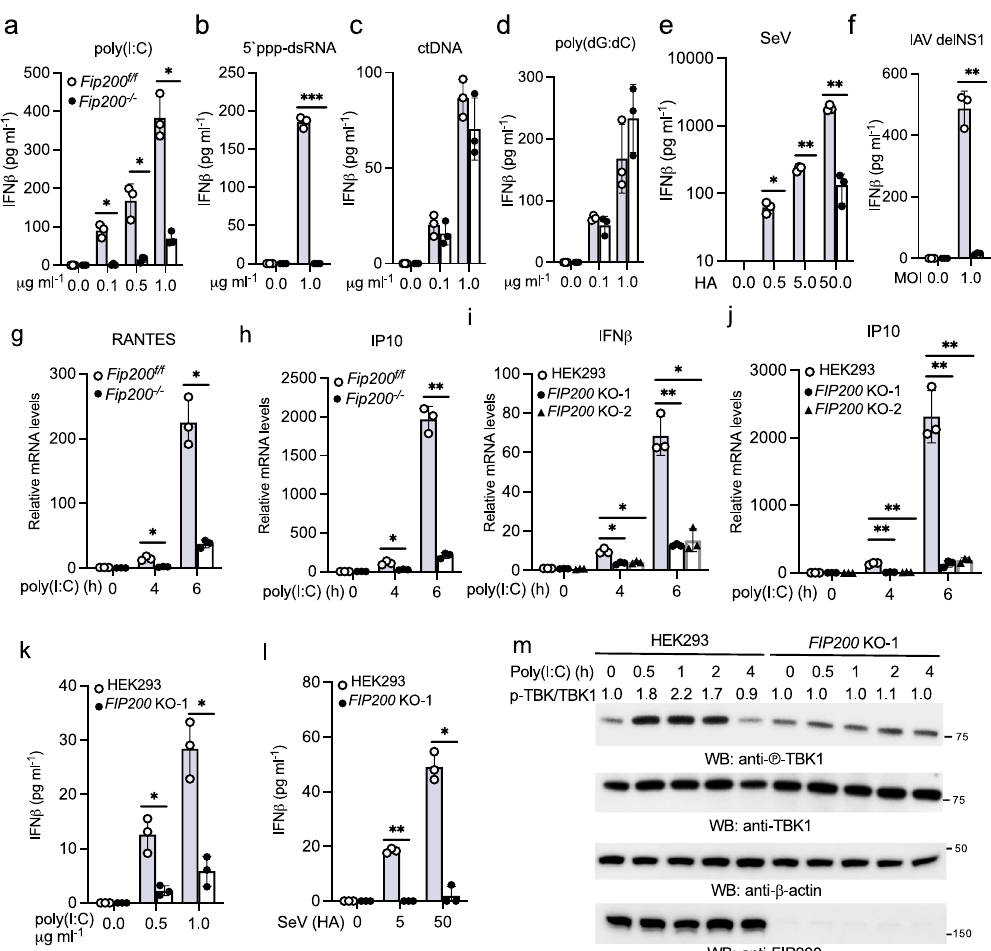
Fig. 3 FIP200 de fi ciency impairs RIG-I activation in fi broblasts. a – d Fip200 f/f and Fip200 − / − MEFs were transfected with indicated amount of poly(I:C) ( a ), 5 ′ ppp-dsRNA ( b ), calf thymus DNA (ctDNA) ( c ), or poly(dG:dC) ( d ). After 16 h, the supernatants were collected for IFN β ELISA assays. All experiments were biologically repeated three times. Data represent means ± s.d. of three independent experiments. The P- value was calculated (two-tailed Student ’ s t test) by comparison with the Fip200 f/f cells. * P < 0.05, *** P < 0.001. e , f Fip200 f/f and Fip200 − / − MEFs were infected with Sendai virus